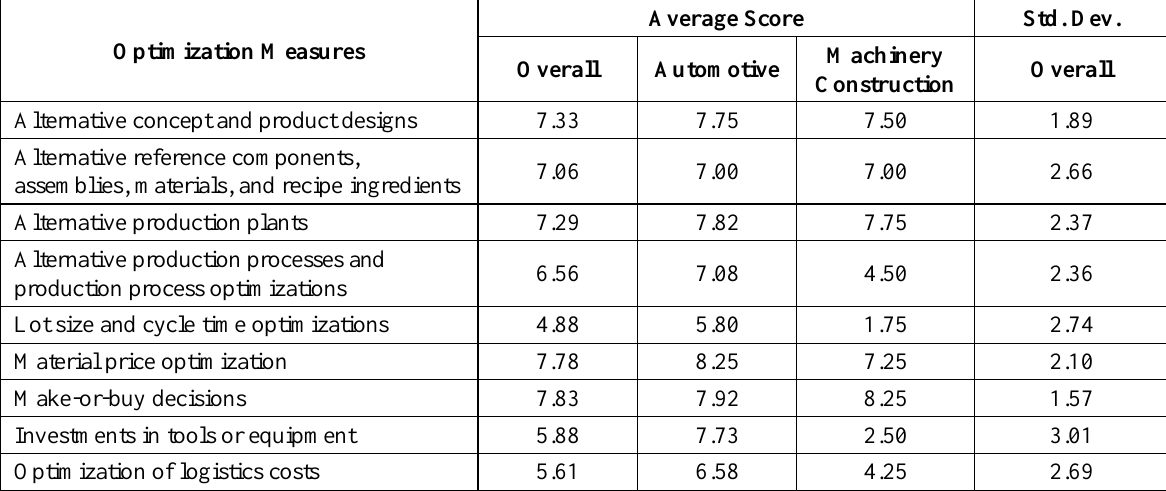
Table 5. Evaluated optimization